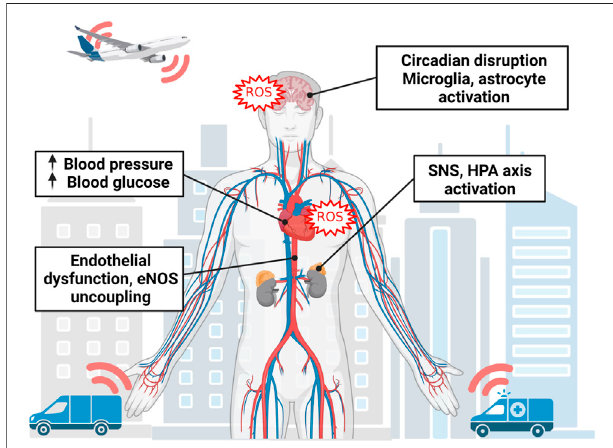
FIGURE 1 | Overall mechanism of noise-triggered adverse health effects. Noise perception starts in the brain leading to neuronal activation in association with disruption of circadian rhythms (especially by nighttime noise causing sleep deprivation and fragmentation), neuroin fl ammation and cerebraloxidativestress.Noiseactivatesdown-streamstressresponsessuch as activation of the sympathetic nervous system (SNS) and the hypothalamic- pituitary-adrenal (HPA) axis leading to stress hormone release such as catecholamines and cortisol with secondary activation of the renin- angiotensin-aldosterone system. This cascade will converge in oxidative stress and in fl ammation in association with eNOS uncoupling, endothelial dysfunction and high blood pressure as well as hyperglycemia, well-known triggers of cardiovascular sequela. Image was created using